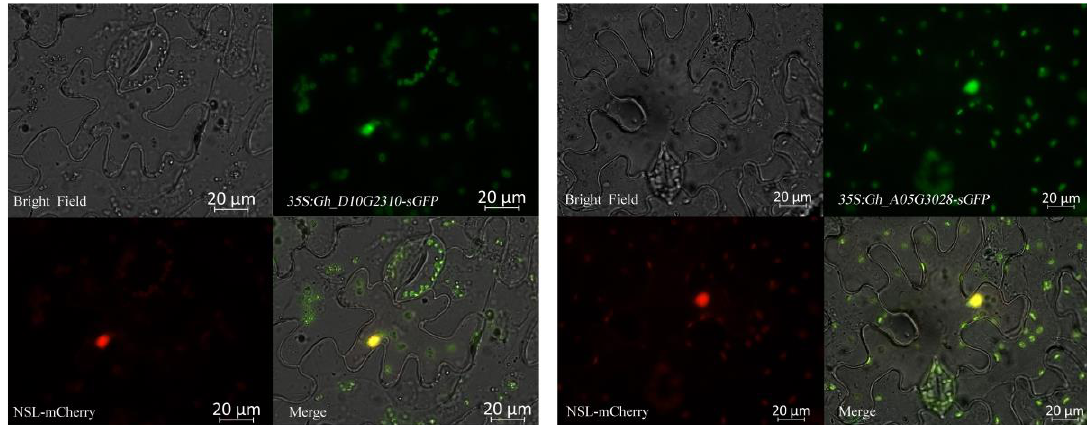
Figure 9. Subcellular localization of two selected GhRCC1 proteins. GhRCC1 and GFP (green fluorescent protein)-fusion proteins were transiently expressed in epidermal cells of tobacco driven by the CaMV35S promoter. Nuclear localization sequence-fused reporter gene mCherry was used as a nucleus-located marker. Bar = 20 μm.